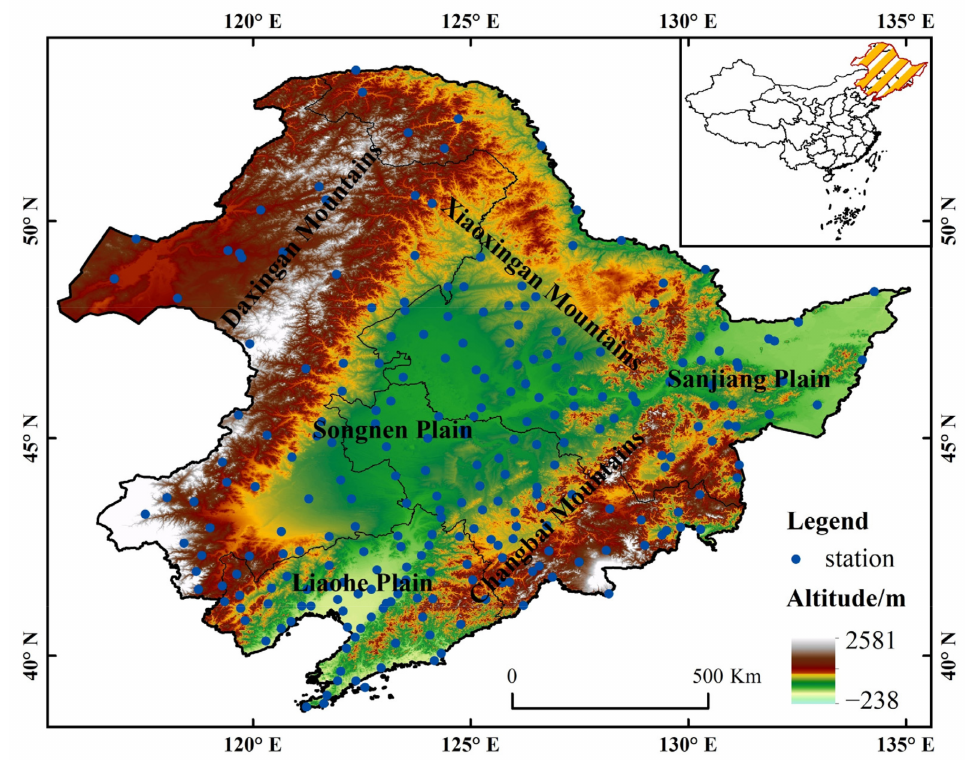
Figure 1. Topography and station distribution in the study area.